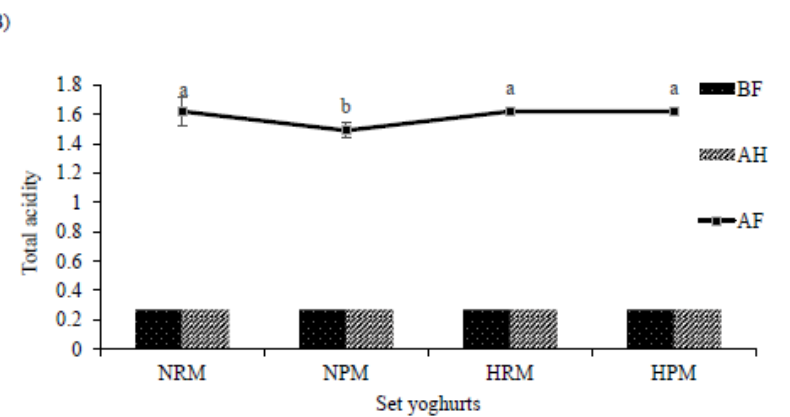
Figure 3. pH values ( A ) and total acidities ( B ) of set yogurts enriched with MFGM produced from raw milk or processed milk under pressure homogenization. BF: Before fermentation; AF: After fermentation; AH: After heating. NPM: Non-homogenized processed milk, NRM: Non-homogenized raw milk, HRM: Homogenized raw milk, HPM: Homogenized processed milk. a, b represent the significant differences in the total acidity among set yoghurts. The total acidity is expressed as % lactic acid